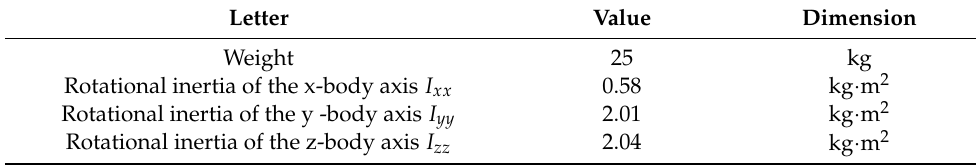
Table 1. The model inertia parameters.